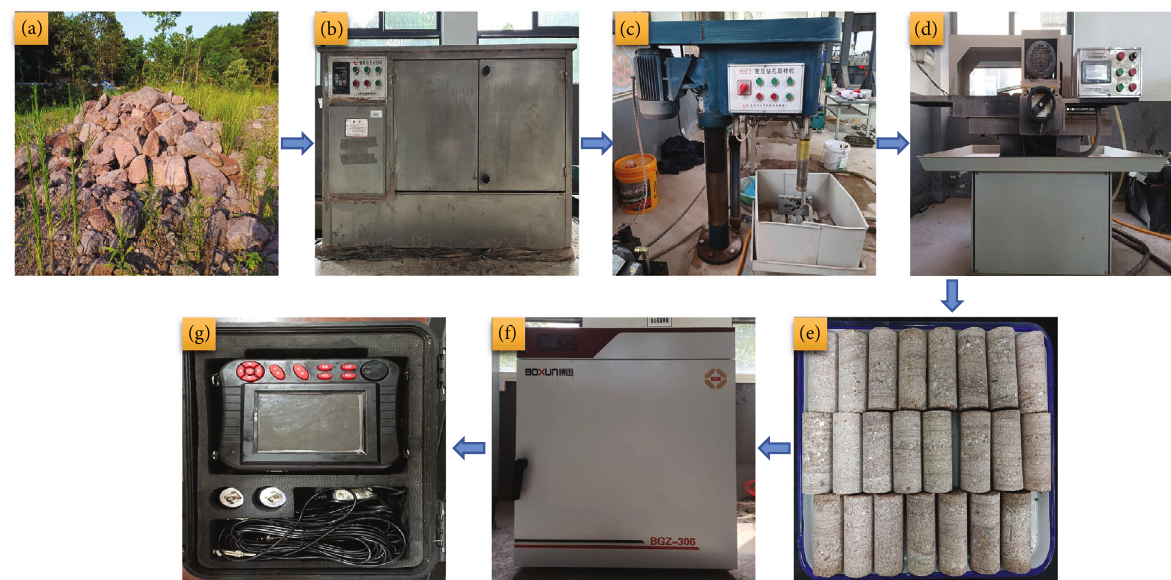
Figure 2: Sample processing and screening process.